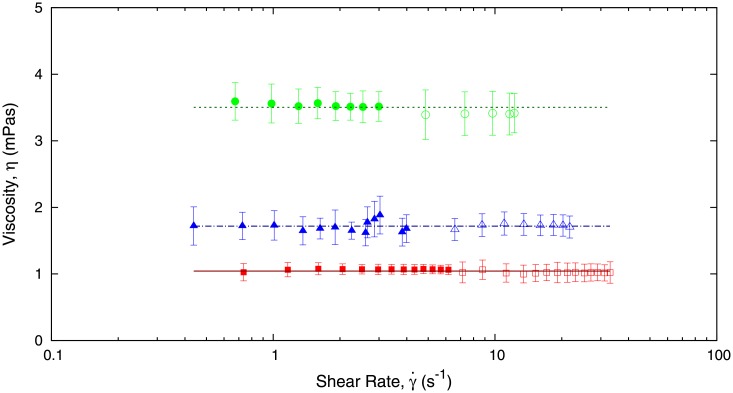
In this plot we use the data shown in Fig 8 to estimate the viscosity of the fluids (water (red squares), blood plasma (blue triangles), and ethylene glycol at 44% dilutions (green circles)) using Eq (15).We observe that for a wide range of values of the shear rate (expanding two orders of magnitude), the viscosity is constant, as it should be expected for a Newtonian fluid. We have used two capillaries with different heights: b = 150 μm (empty symbol) and b = 300 μm (solid symbol).